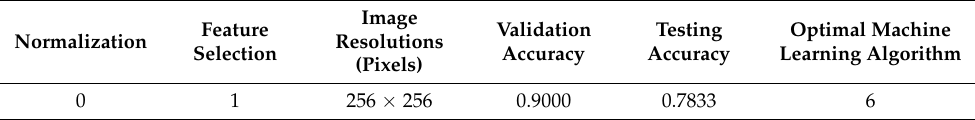
Table 1. Validation and testing five-category accuracies of the optimal CAD with homology-based image processing in the private dataset. Note: The optimal CAD was selected based on the validation accuracies of Table